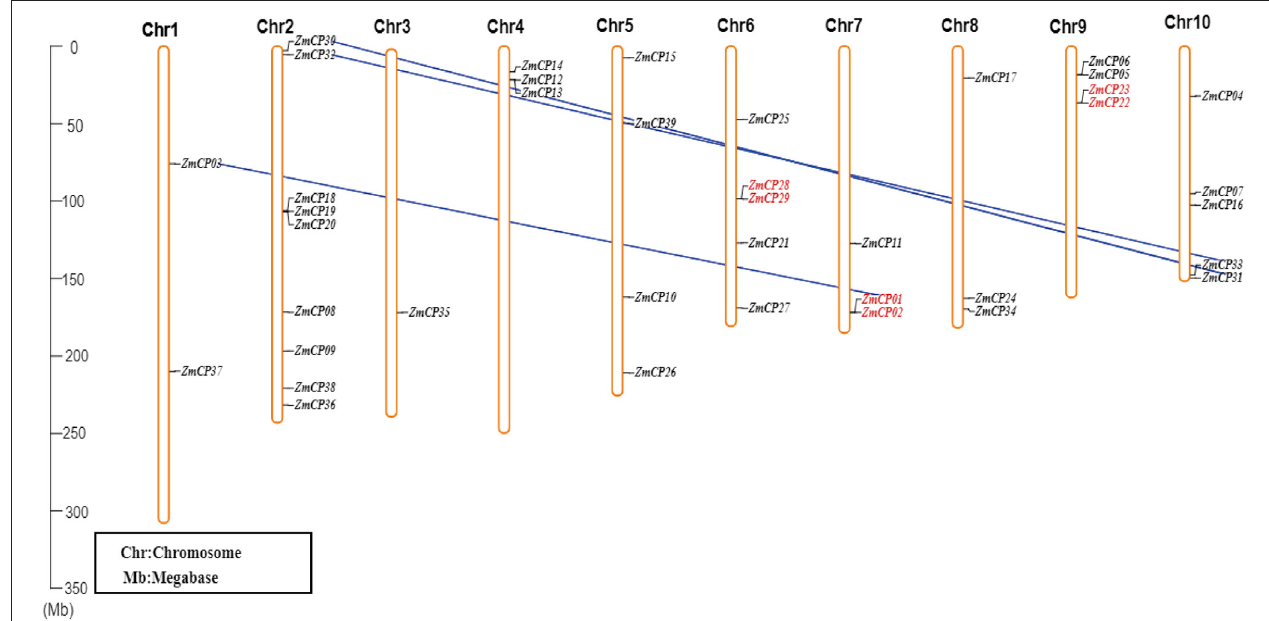
FIGURE 4 | The chromosomal distribution of ZmCP genes. The left scale represents the length of the chromosomes. The chromosomal segmental duplications between two ZmCP genes are displayed by blue lines, and the two ZmCP genes that occurred as tandem duplication events are indicated in red.